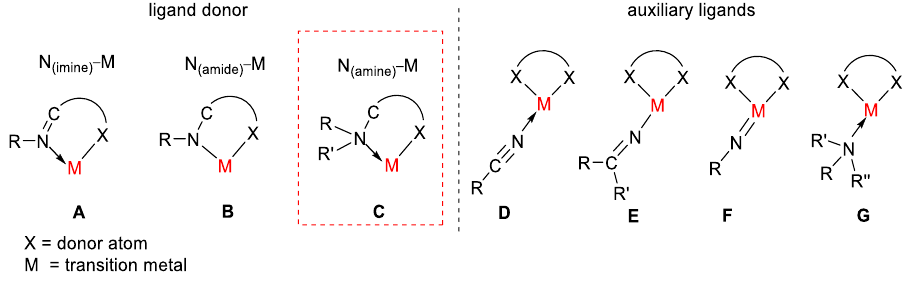
Figure 1. Combination modes (A – G) between the nitrogen donor atom and the transition metal.